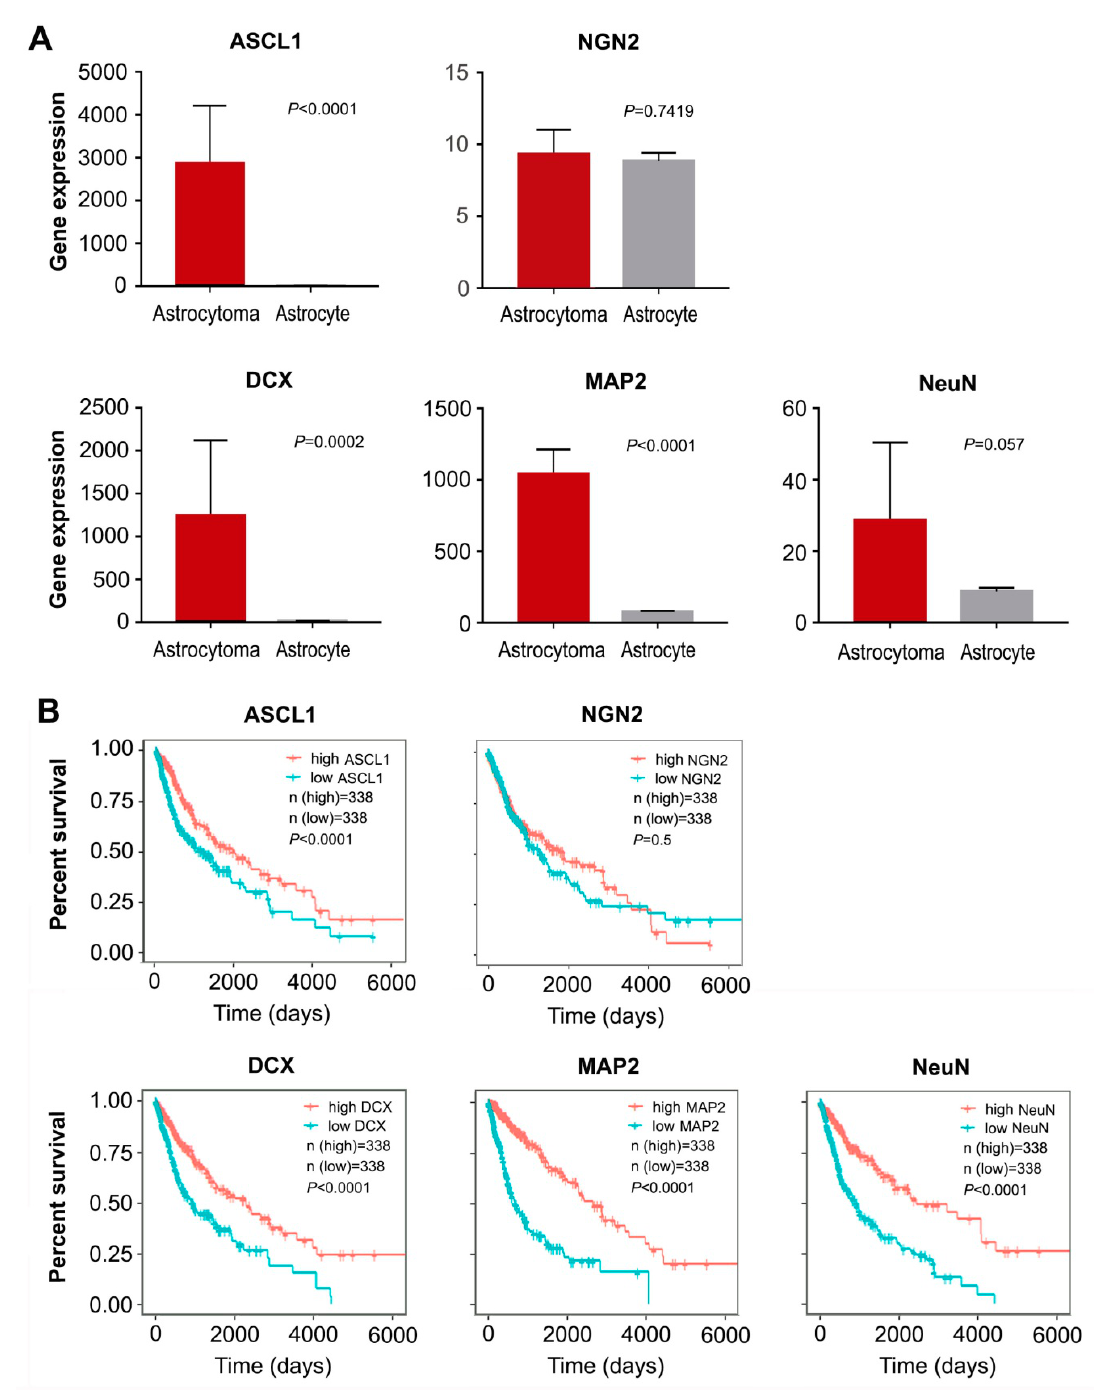
Figure 2. Data analysis from GEO and TCGA. ( A ) The differential expression of transcription factors (ASCL1 and NGN2) and neuronal markers (DCX, MAP2 and NeuN) in human astrocytoma and astrocytes from the data obtained from GEO (mean ± SD, Student’s t -test). ( B ) Analysis of gene expression and survival curves based on the data of 676 glioma samples obtained from TCGA.